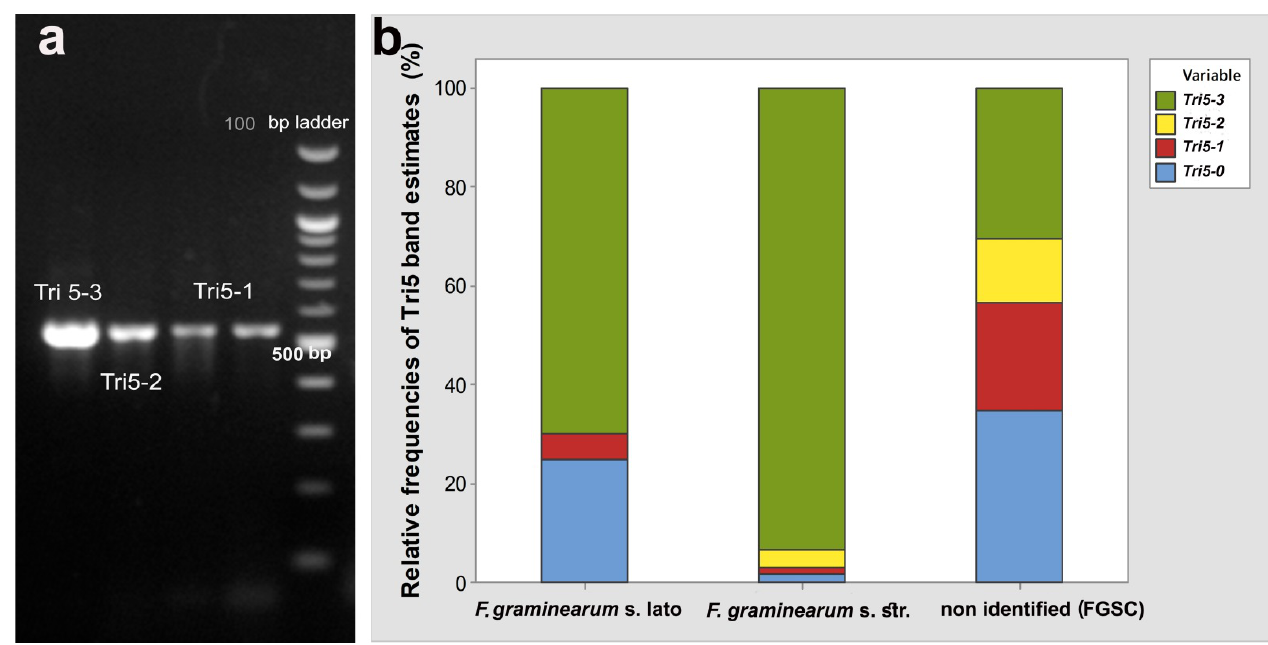
Figure 4. Tri-5 genotyping and potential for mycotoxin production of 210 FGSC ( F. graminearum species complex) isolates from Serbia. ( a ) Qualitative Tri-5 -specific PCR assay resulting in three levels of Tri-5 DNA band intensities; ( b ) relative frequencies of Tri5 band intensity estimates among F. graminearum s. stricto, F. graminearum s. lato, and nonidentified (FGSC).